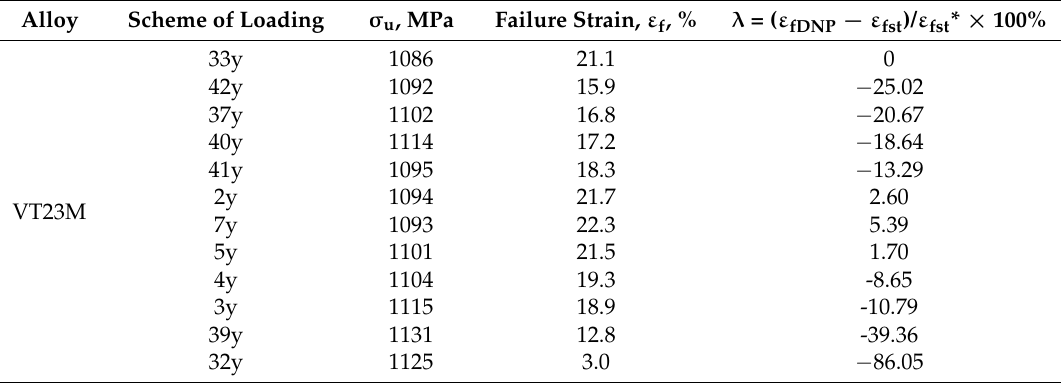
* ε fst —failure strain of the specimen during static